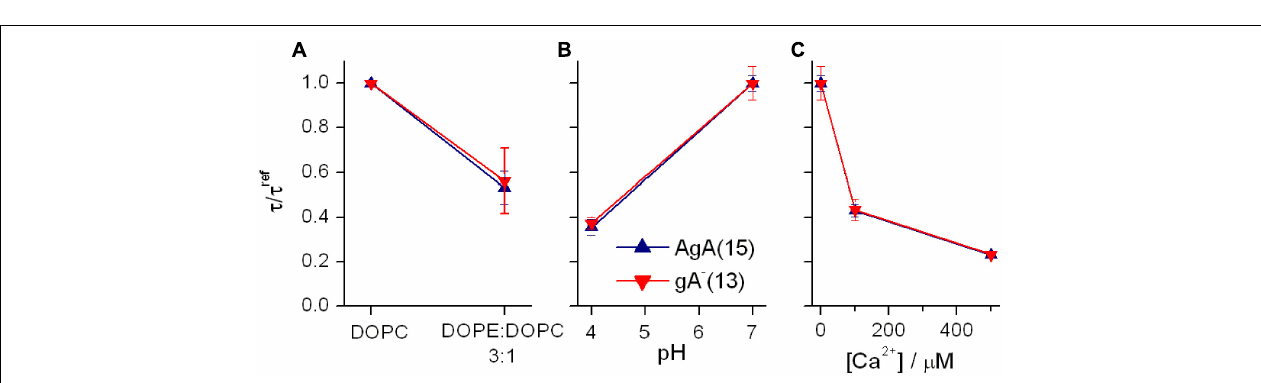
FIGURE 7 | AgA(15) and gA − (13) channel function in DOPE:DOPC/ n -decane bilayers. (A) Current transition amplitude histograms. The lower amplitude peaks, highlighted in red, denote gA − (13) channels; the higher amplitude peaks, highlighted in blue, the AgA(15) channels. (B) The corresponding normalized single-channel duration histograms (the colors have same significance as in (A) . The results from single experiments fitted by single exponential distributions. 1 M NaCl, pH 7, 200 mV, 500 Hz.